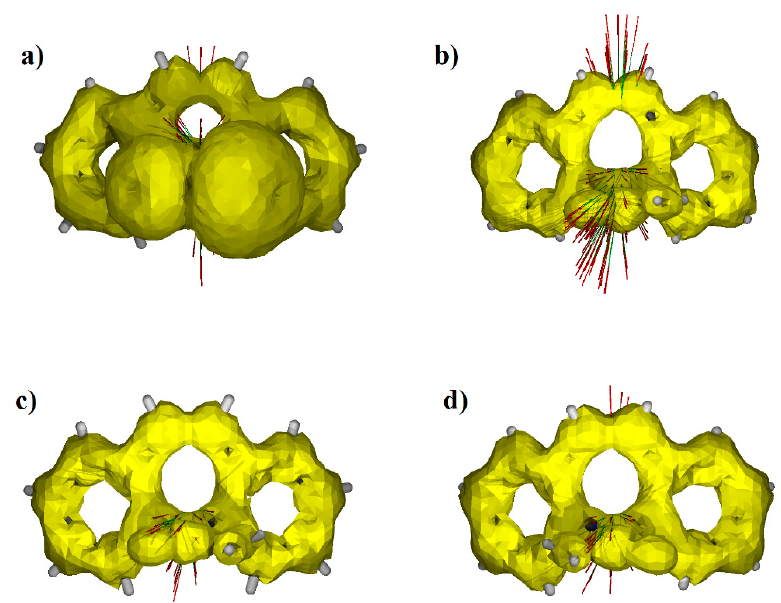
Figure 8. ACID surfaces for selected 5 H ‐ dibenzo[b,f]azepine derivatives with different aromaticity of the middle ring. The HOMED value for VUBCAW [67] is 0.7816 ( a ), for CBMZPN32 [ 52 ] − 0.0896 ( b ), for TAZRAO01 [68] 0.6732 ( c ) and for HEMRIB [63] − 0.2506 ( d ). Replacing of the double bond in the middle ring with a single one caused the central ring to express less aromaticity. Substitution of the compound can cause the HOMED value for the middle ring to be higher than for a typical unsubstituted ring (Figure 9). Relatively high HOMED value and electron delocalization is connected with the presence of the lone pairs on the nitrogen atom and the aromatic bonds common for the central and the side ring.